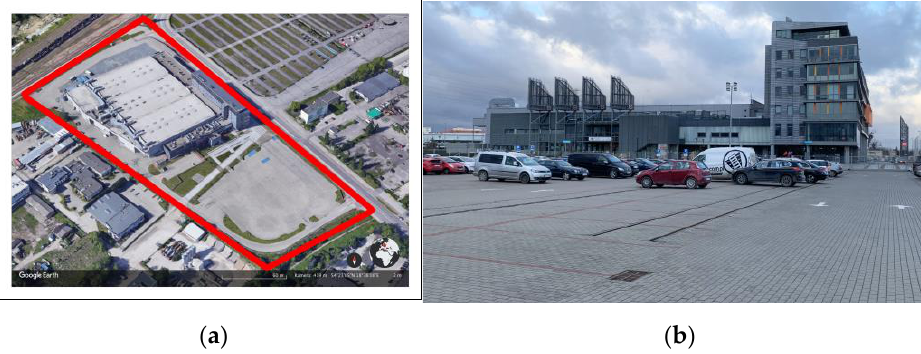
Figure 1. ( a ) Location and development around the Gdansk International Fair building in Gdansk, Poland (source: Google Earth). ( b ) View of the MTG entrance area (photo: Agnieszka Gebczynska- Janowicz).